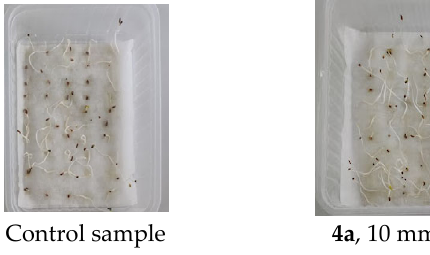
Figure 5. Sowing qualities of alfalfa seeds.